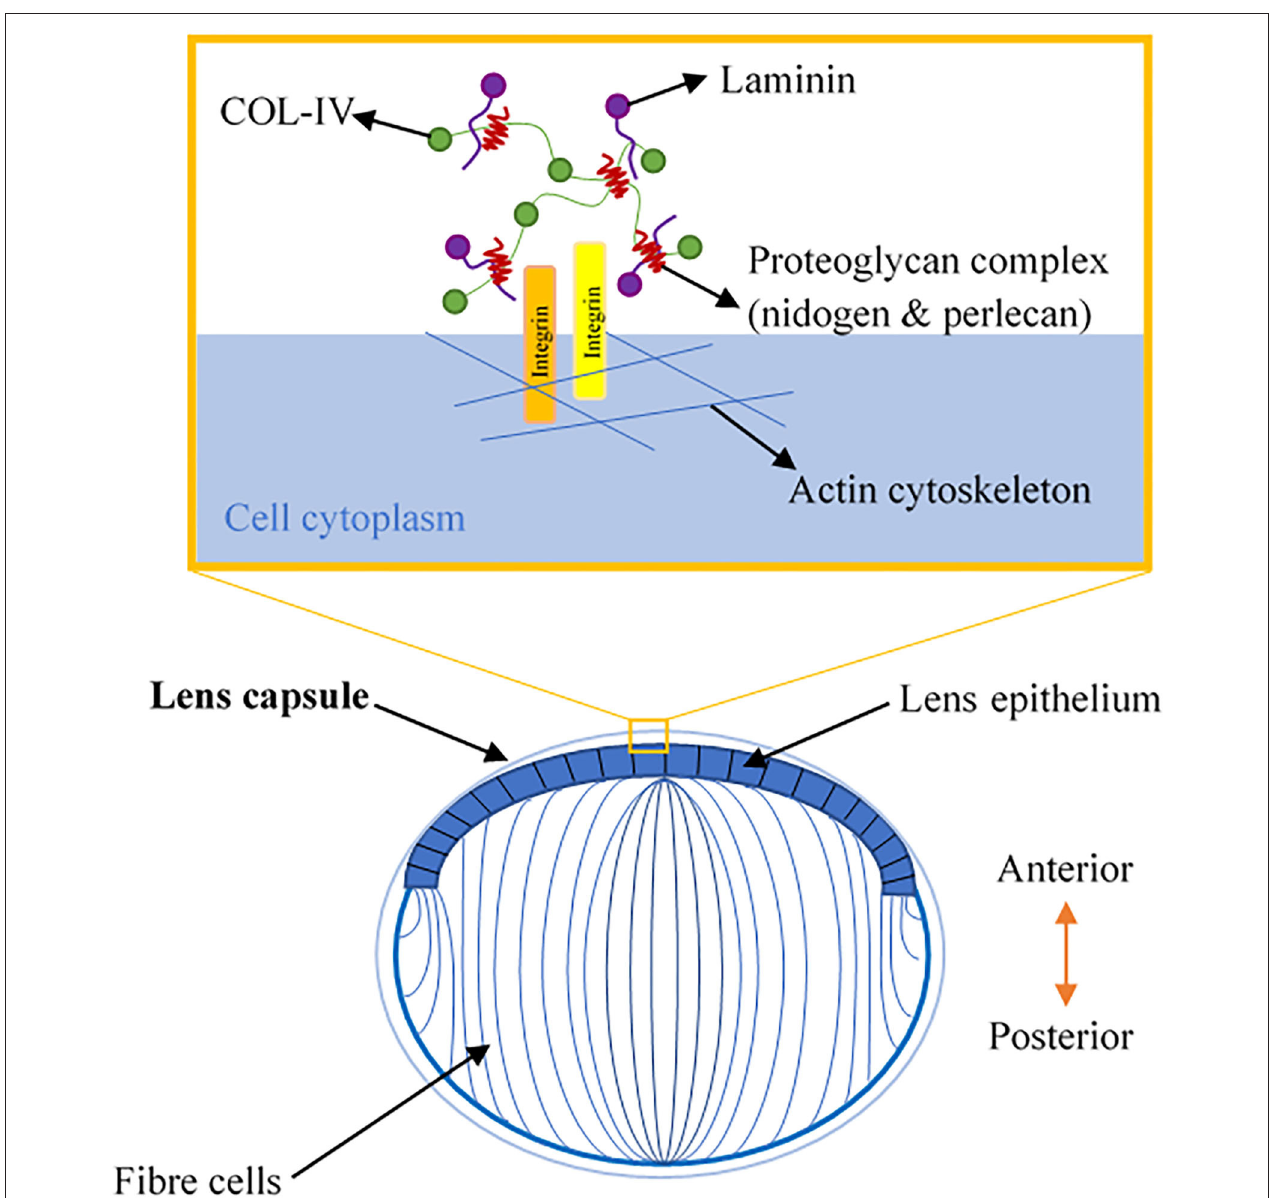
FIGURE 2 | A schematic illustration of lens anatomy and the matrix composition of the lens capsule in the enlarged area.